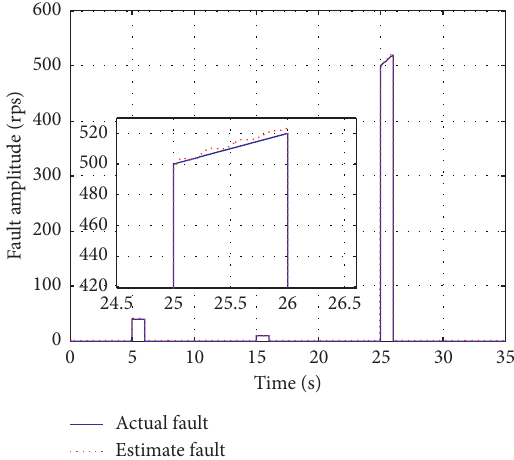
Figure 4: Fault estimation of the method in this